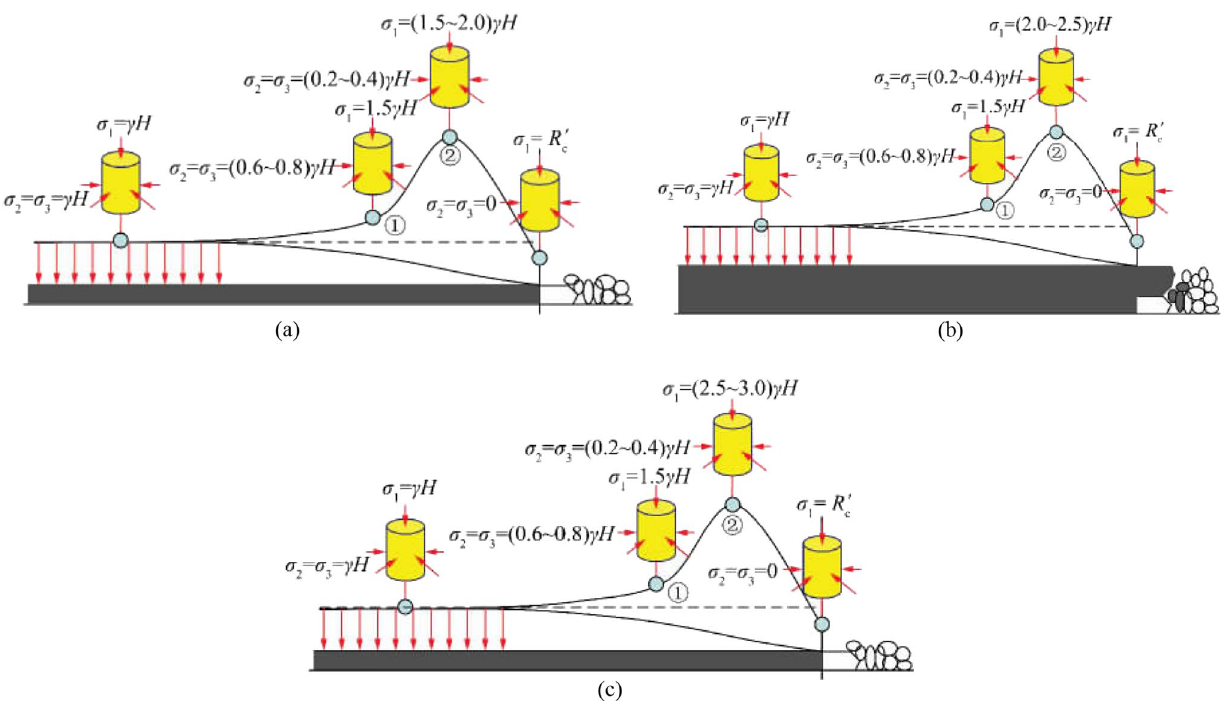
Fig. 4 Three kinds of mining actual stress paths (Xie et al. 2011): a Protected coal seam mining, b Top-coal caving mining, c Non-pillar mining